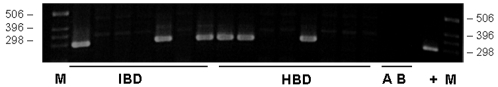
Nested PCR detection of MAP DNA from peripheral blood samples.Shown are representative samples of IBD patients and Controls. M = molecular weight marker, lane A = negative control of first round of PCR, lane B = negative control of second round of PCR, +  =  DNA from MAP strain ATCC 19698.